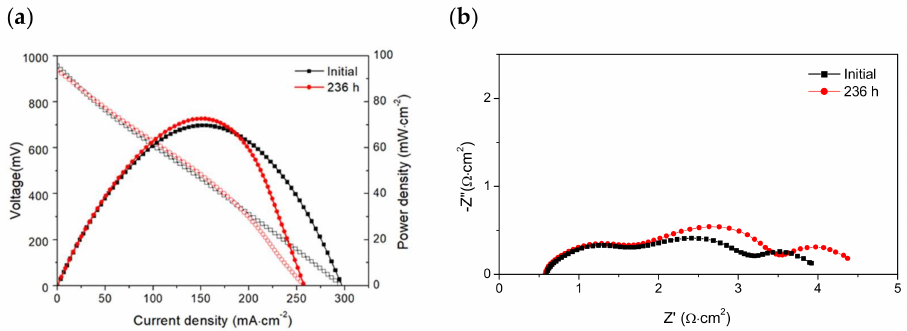
Figure 4. ( a ) I-V curves and ( b ) impedance spectra of the cell (Ni-CYSZ / YSZ / LSM) at 850 ◦ C in wet CH 4 (3% H 2 O) before and after the long-term stability test (236